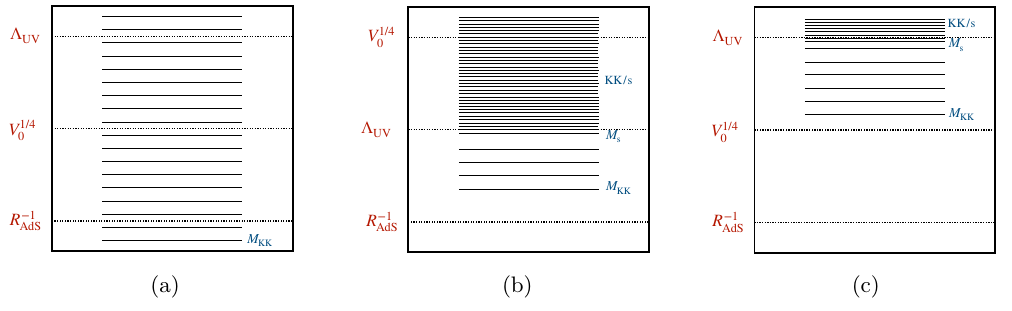
Figure 4 . Structure of towers and scales in four dimensions: (a) A theory with a single tower of particles with α = 1 / 2 . No scale separation. (b) The structure of towers in DGKT-CFI models, with two towers of particles and one of strings. There is scale separation, with some part of the tower below the maximum CKN cut-off V 1 / 4 . (c) A theory with the towers above the CKN 0